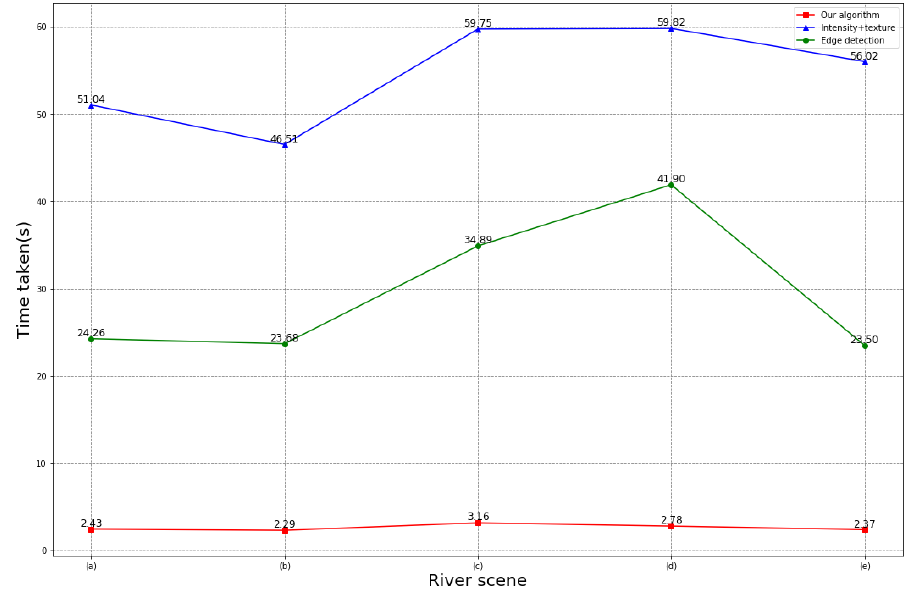
Figure 11. Speed of different methods in simple scenes.